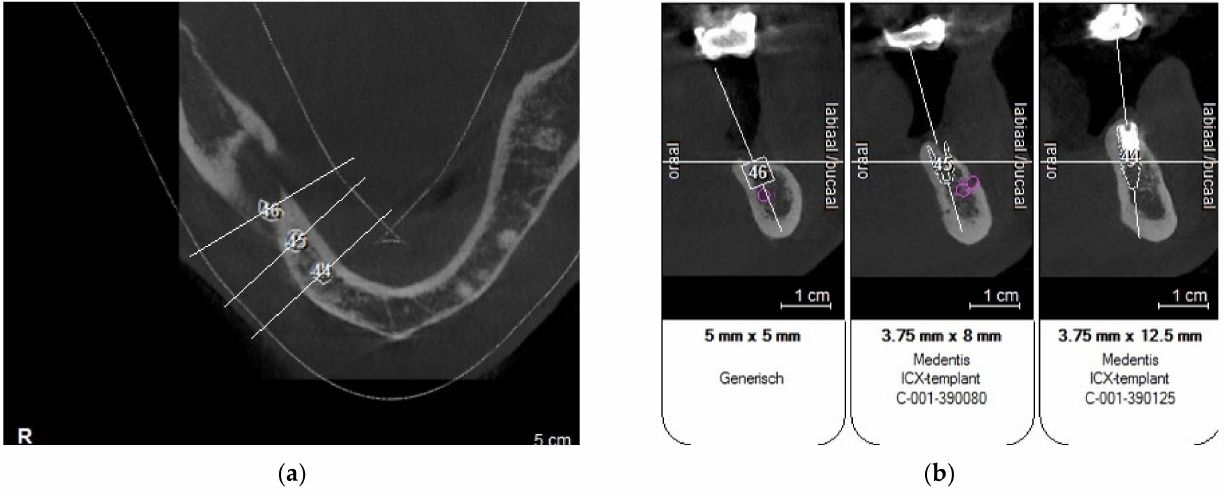
Figure 3. Position of the CBCT slice ( a ) showing the exact location of the canal ( b ).